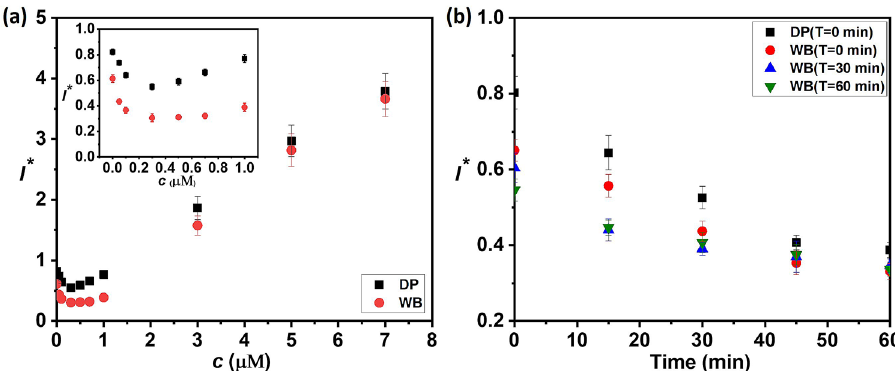
Figure 3. ( a ) Variation of FL intensity with H 2 O 2 concentration measured using the microfluidic device, in human whole and deproteinized plasma. ( b ) Variation in FL intensity with measurement time points (t) for whole plasma, after the plasma gets separated at different time points (T) and deproteinized plasma (with T = 0). In all cases centrifuged plasma and on-chip mixing/incubation are used, here DP—deproteinised plasma, and WB—whole blood plasma. (Each data point represents the standard deviation (SD) from three different